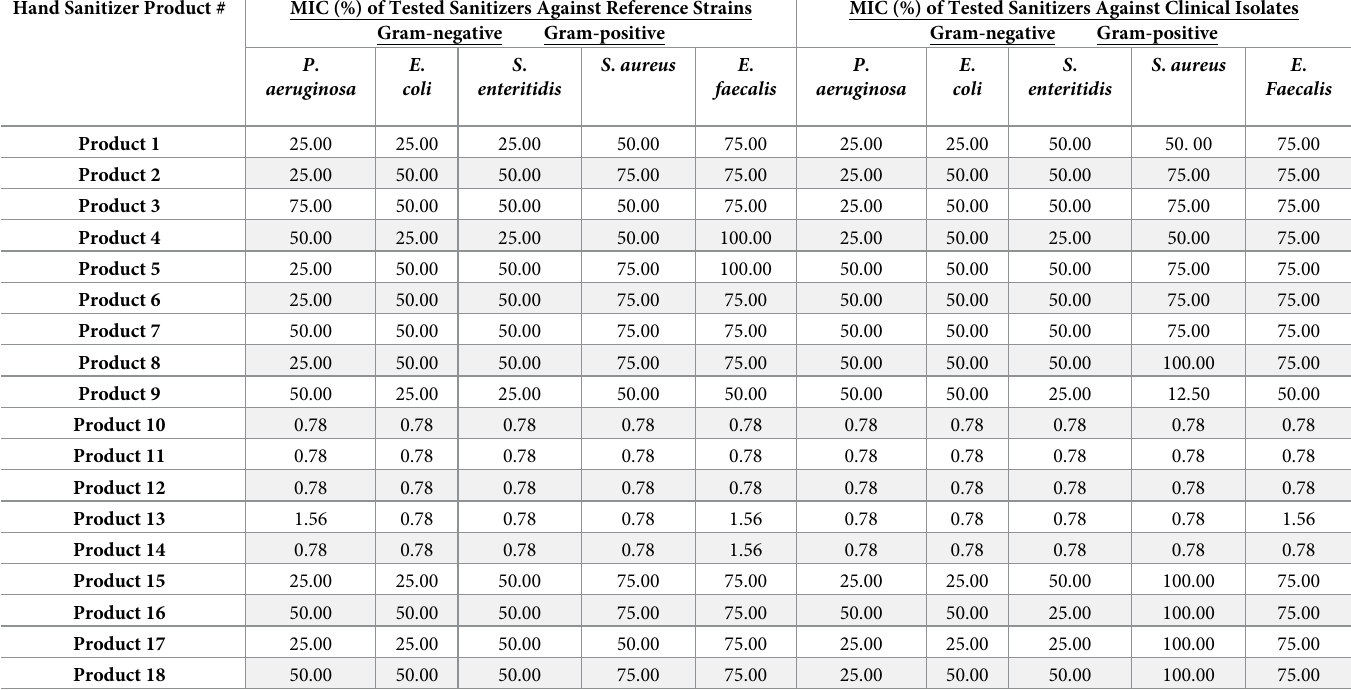
Table 2. This table demonstrates the MIC% of all disinfectant products in inhibiting the growth of five bacterial species of ATCC reference strain and clinical isolates �